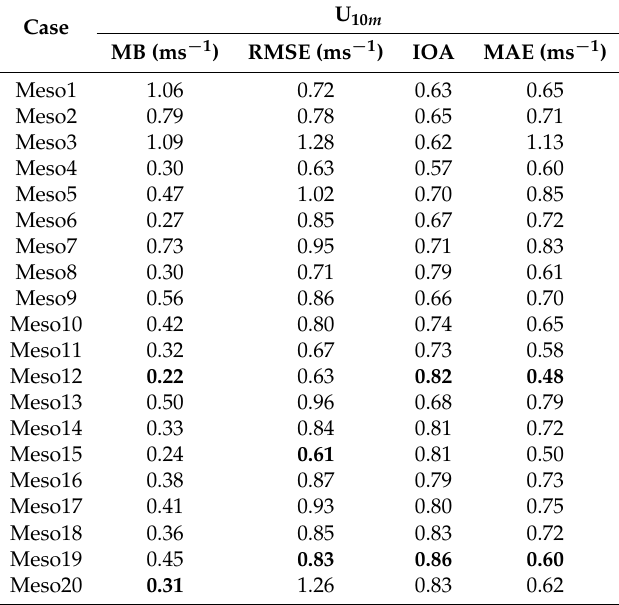
Table A2. Statistical measures for 10-m wind speed in mesoscale simulations performed. Bold values represent the best values.